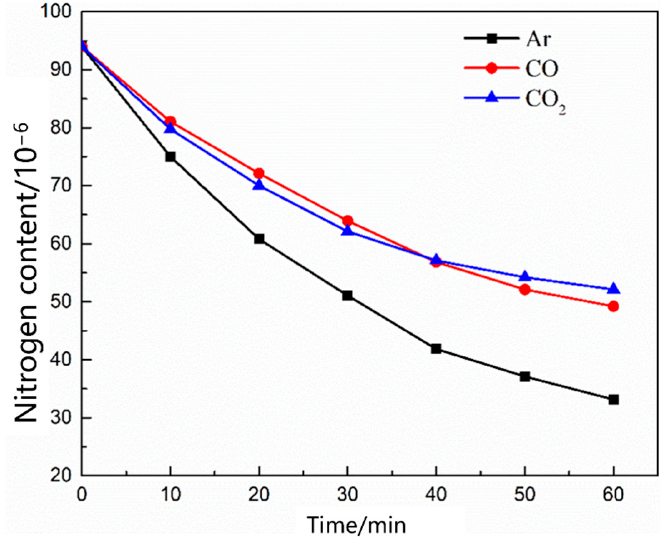
Figure 13. Change in the nitrogen content in the different gases of the oxygen-free molten steel. Equation (8) is obtained by combining Equations (4)–(6) and integral transformation,